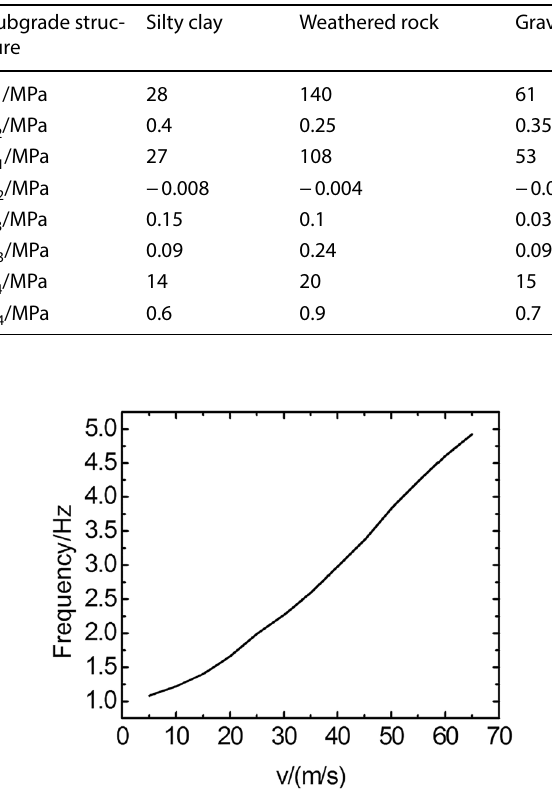
Fig. 4 Taxiing speed and frequency